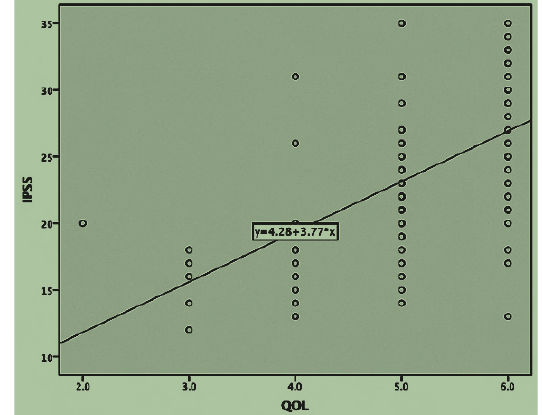
Figure 2. Scatter diagram-showing correlation between IPSS and